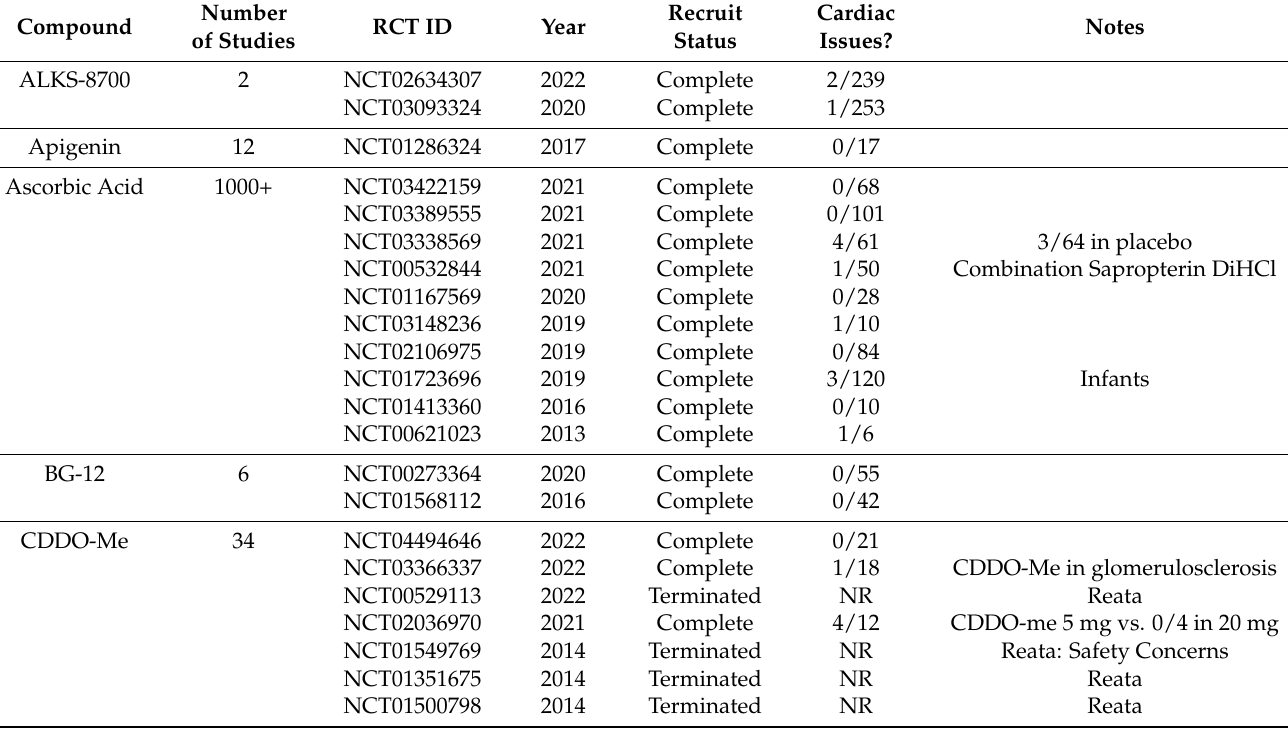
Table 6. Selected clinical trial updates and dispositions for Nrf2 Exogenous Regulators (data from